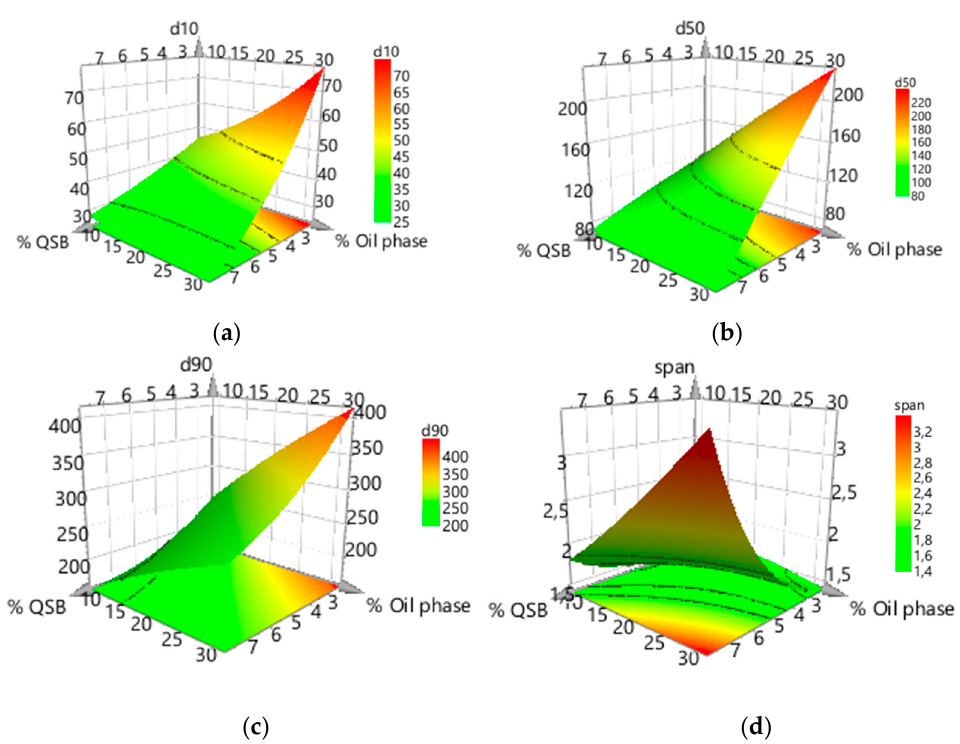
Figure 3. Isoresponse curves (graph floor) and response surface plots of relative size distribution (µm), respectively: ( a ) d(10), ( b ) d(50), ( c ) d(90) and ( d ) span, for formula optimization. % QSB—% Quercus Suber Bark particles.